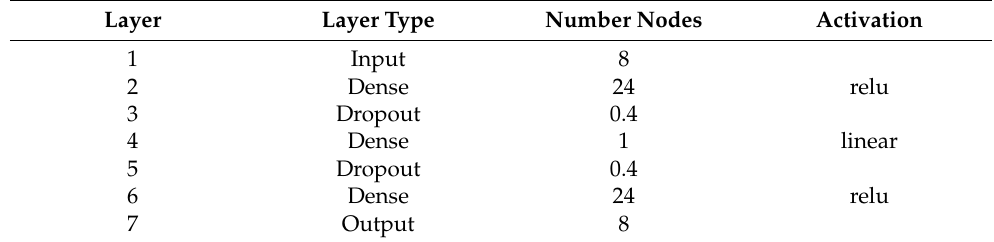
Table 1. Autoencoder architecture with hyper-parameters. Layer Layer Type Number Nodes Activation 1